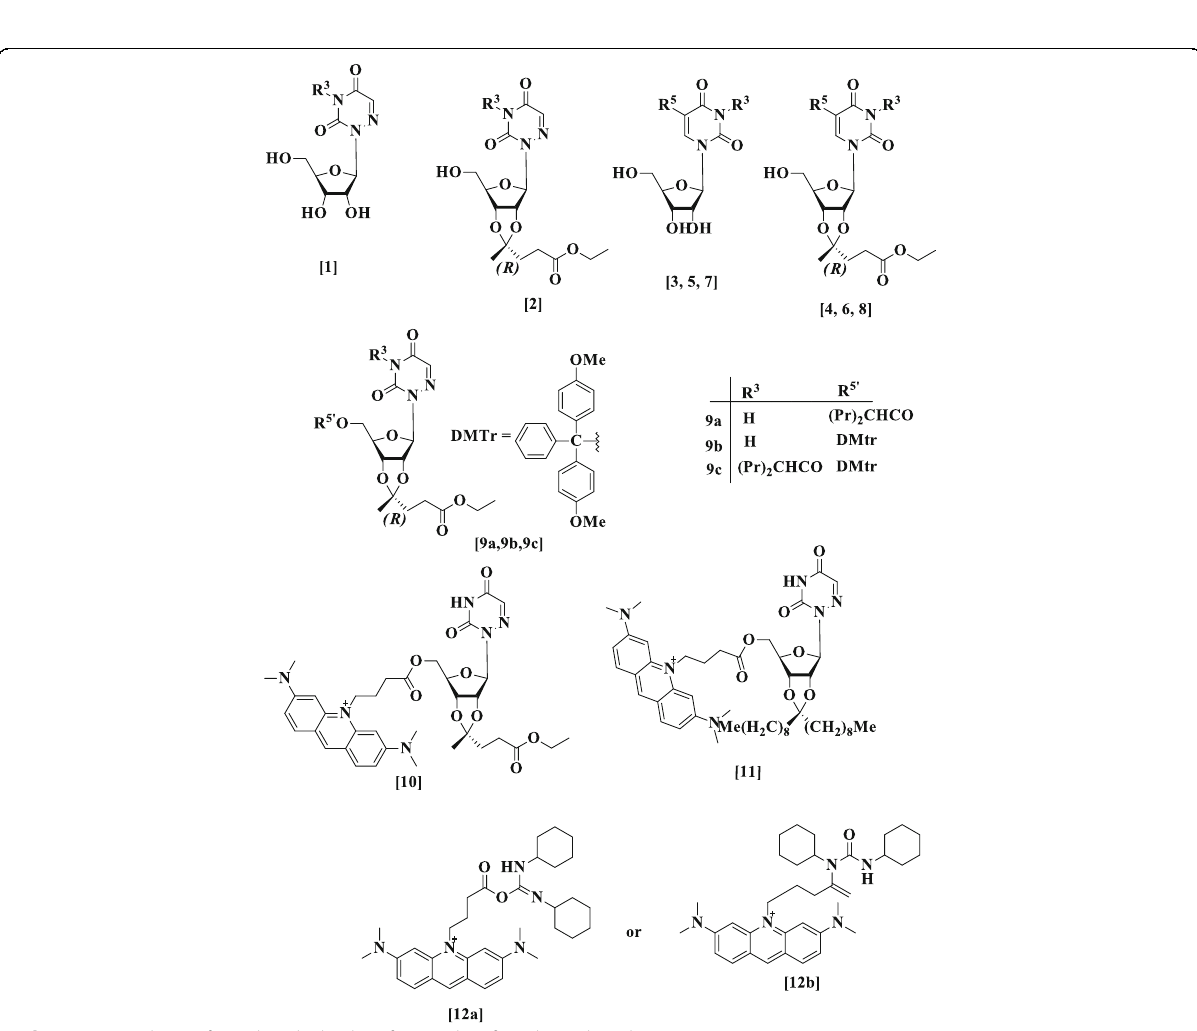
Scheme 39 Synthesis of novel nucleolipides of pyrimidine β -D-ribonucleosides [1 –